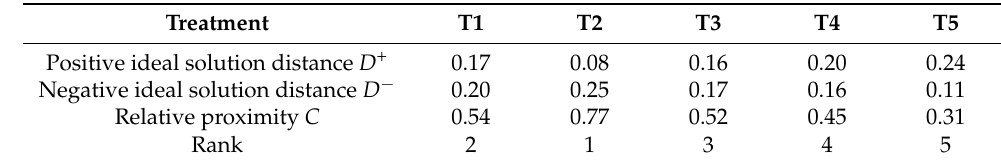
Table 5. The results of entropy weight by TOPSIS comprehensive